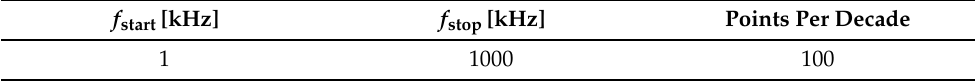
Figure 4. Equivalent circuit and LTSpice directives used in the circuit parametric simulation. Table 1. WPT excitation frequency interval in which the parametric simulation is carried